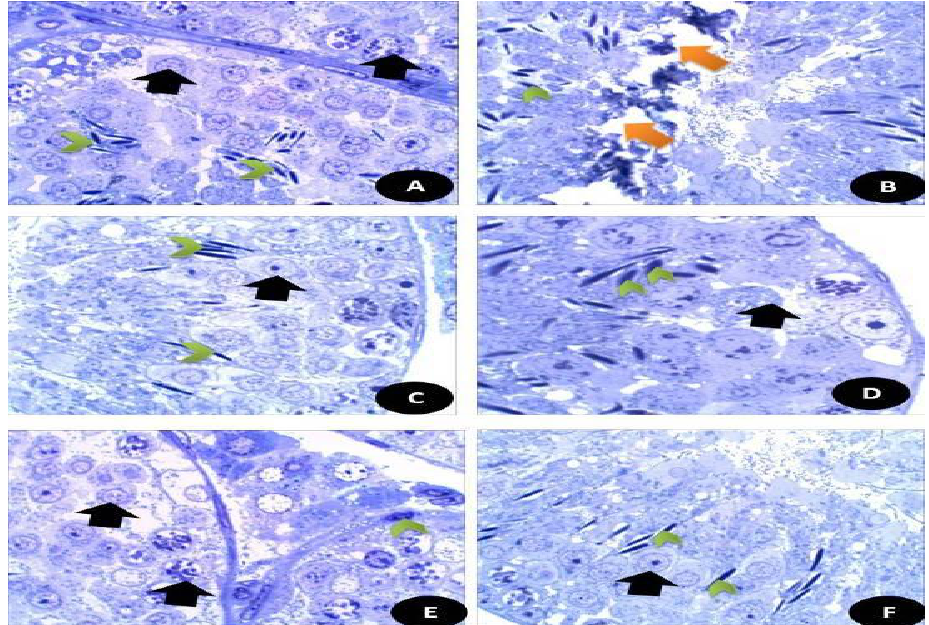
Figure 12. Semi-thin sections of the testicular tissues stained with toluidine blue stain. ( A ) Control normal appearance of testis tissues with normal spermatogenic stages and cells (Black arrow) with appearance of normal sperms (Green head arrow) ( × 400). ( B ) DG-treated rats showed highly degree of damage appeared by disintegration of testicular tissues (Orange arrow) with appearance of fewer sperm number (Green head arrow) ( × 400). ( C ) Q treated group showed normal appearance of testicular section with complete stages of spermatogenesis (Black arrow) with moderate number of sperms (Green head arrow) ( × 400). ( D ) Ru III /Q treated group showing normal healthy appearance of testicular tissues with normal spermatogenic tissues (Black arrow), with high number of mature sperms ( × 400). ( E ) DG + Q treated group showing partial restoration of testicular tissues with less spermatogenic arrest with moderate sized spermatogenic cells (Black arrow) and some appeared disintegrated parts with presence of myoid cells (green head arrow) ( × 400). ( F ) DG + Ru III /Q treated group showing high restoration of testicular tissues with complete spermatogenic cells (Black arrow) and restoration of sperm numbers (Green head arrow).